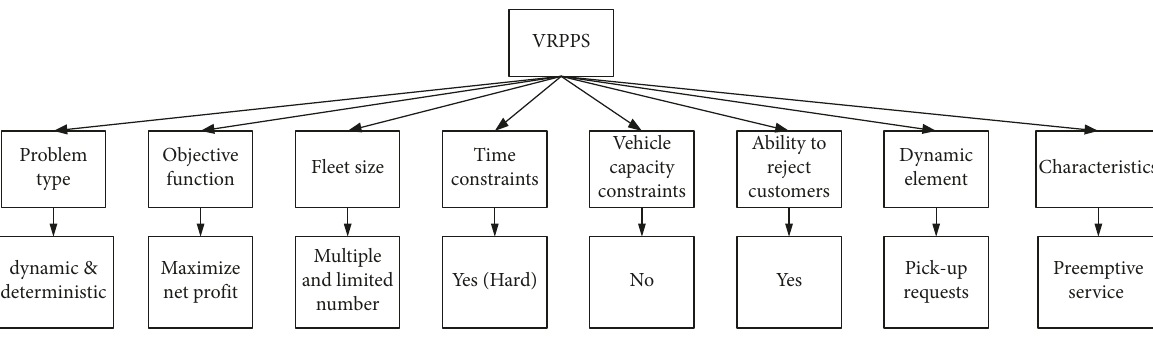
Figure 1: DVRP taxonomy for the proposed VRPPS based on the framework by Psaraftis, Wen and Kontovas